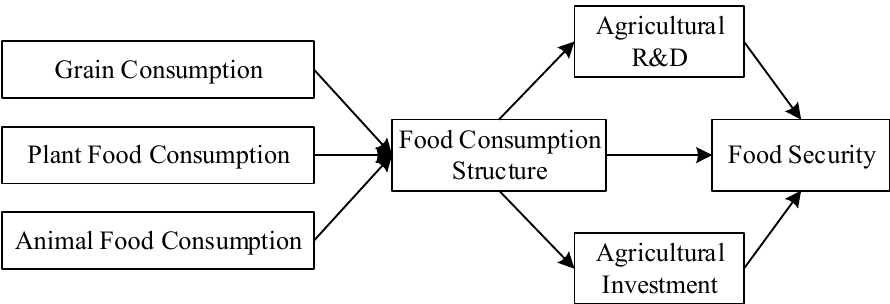
Figure 1. The overall theoretical framework diagram.